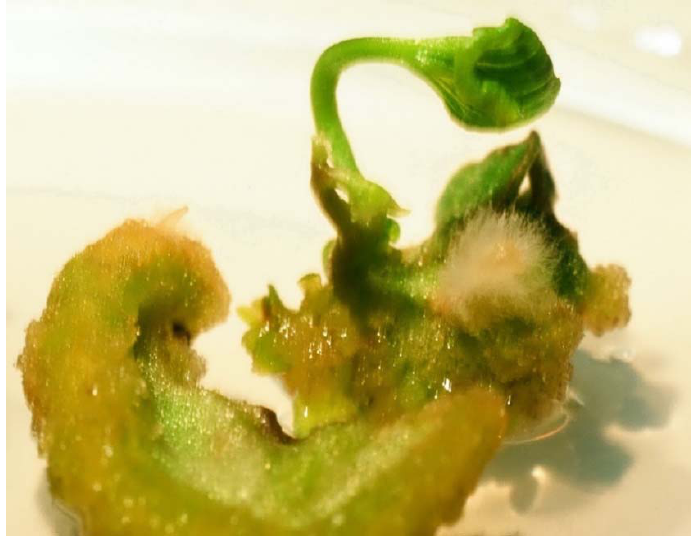
Figure 3. Common buckwheat cotyledons can be used in tissue culture techniques to regenerate several progeny plants with an identical genotype.